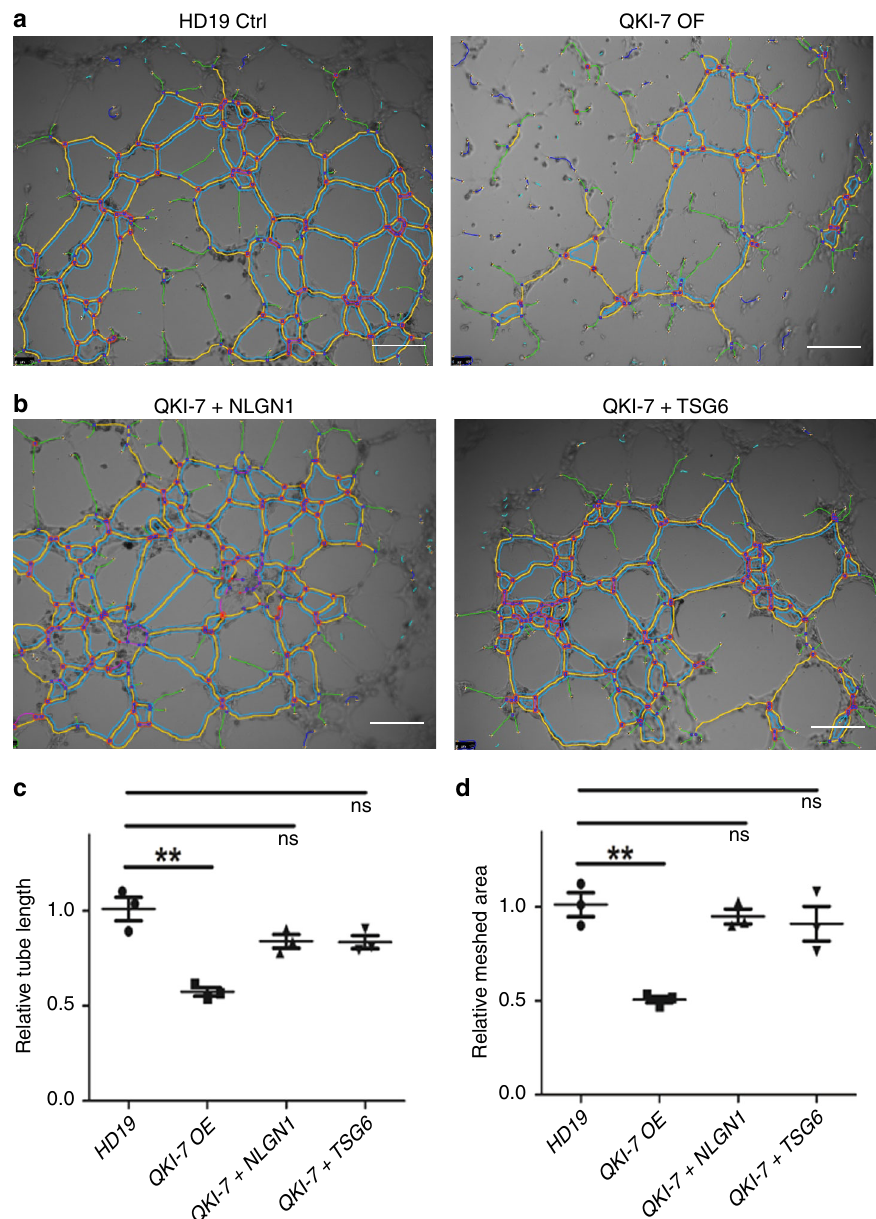
Fig. 6 NLGN1 and TSG6 restored angiogenic capacity antagonizing QKI-7. QKI-7 overexpressing iPS-ECs formed less capillary structure with shorter master segment length ( p value: 0.0034) and smaller meshed area ( p value: 0.0016) in comparison to the control cells (iPS-ECs overexpressing an empty vector) ( a , c , d ). When NLGN1 and TSG6 were co-transfected with QKI-7 into iPS-ECs, the angiogenic capacity was recovered ( b ). No signi fi cant difference was observed between the co-transfection groups and control ( c , d ). Scale bar: 200 μ m. Data are from three biologically independent experiments. Error bars represent mean ± SEM ( n = 3). P values are shown: ** p < 0.01, ns: not signi fi cant (two-tailed t test). The data were normalized by setting the control group as 1. Source data are provided as a Source data fi